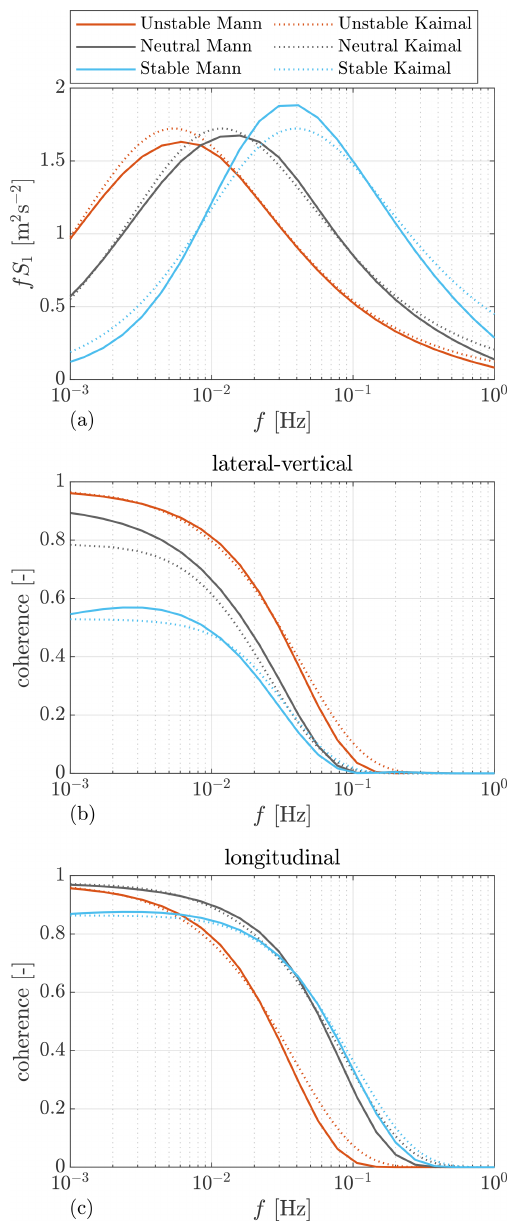
Figure 2. (a) The auto-spectra of the longitudinal velocity compo- nent under different stability classes. (b) Lateral–vertical coherence of the longitudinal velocity component calculated using the Mann spectral tensor and fitted by the exponential coherence model. Note the co-coherence is shown for the Mann spectral tensor. (c) Lon- gitudinal coherence of the longitudinal velocity component calcu- lated using the space–time tensor and fitted by the exponential co- herence model. The results are calculated with a mean wind speed of 16ms − 1